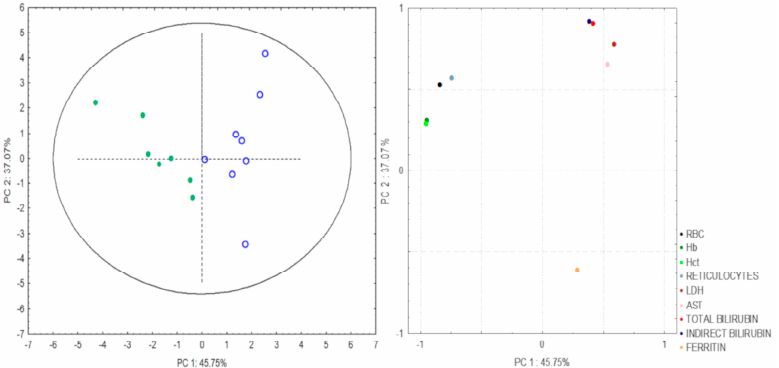
Figure 2. Scores of the samples and loading graph obtained by PC1 and PC2 to determine the association between hemolytic biomarkers and sickle leg ulcers. PC, Principal component; RBC, red blood cells; Hb, hemoglobin; Hct, hematocrit; LDH, lactate dehydrogenase; AST, aspartate aminotransferase.